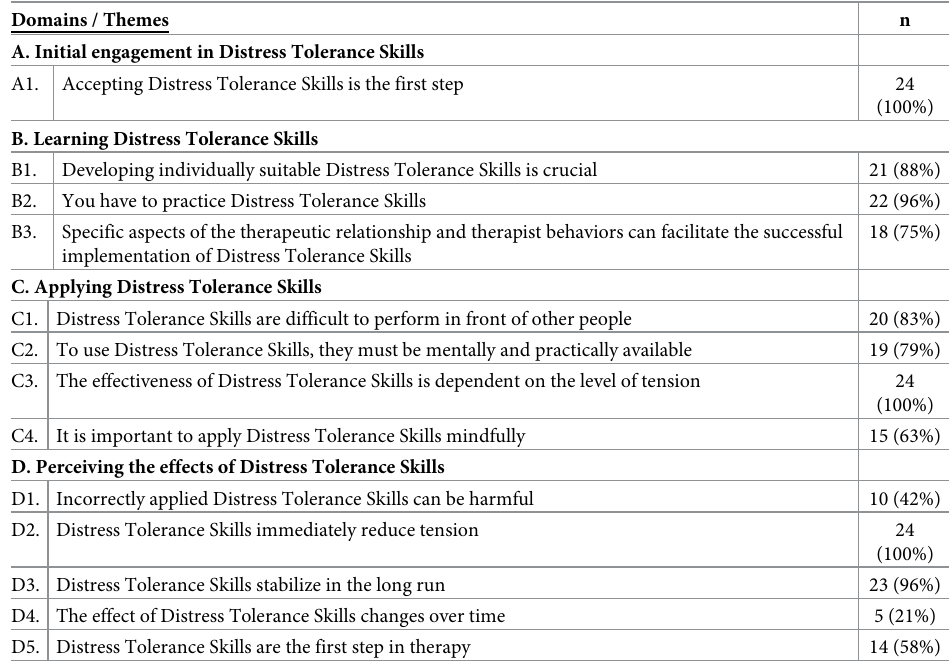
Domain A: Initial engagement in Distress Tolerance Skills. This domain reflects patients’ first involvement with DTS. In order to apply DTS, patients first need to accept the technique and the underlying theoretical model. Theme A1 : Accepting Distress Tolerance Skills is the first step . All 24 patients mentioned the acceptance of DTS to be an integral part of the learning process. This domain was linked to three subthemes with two sub-subthemes each.